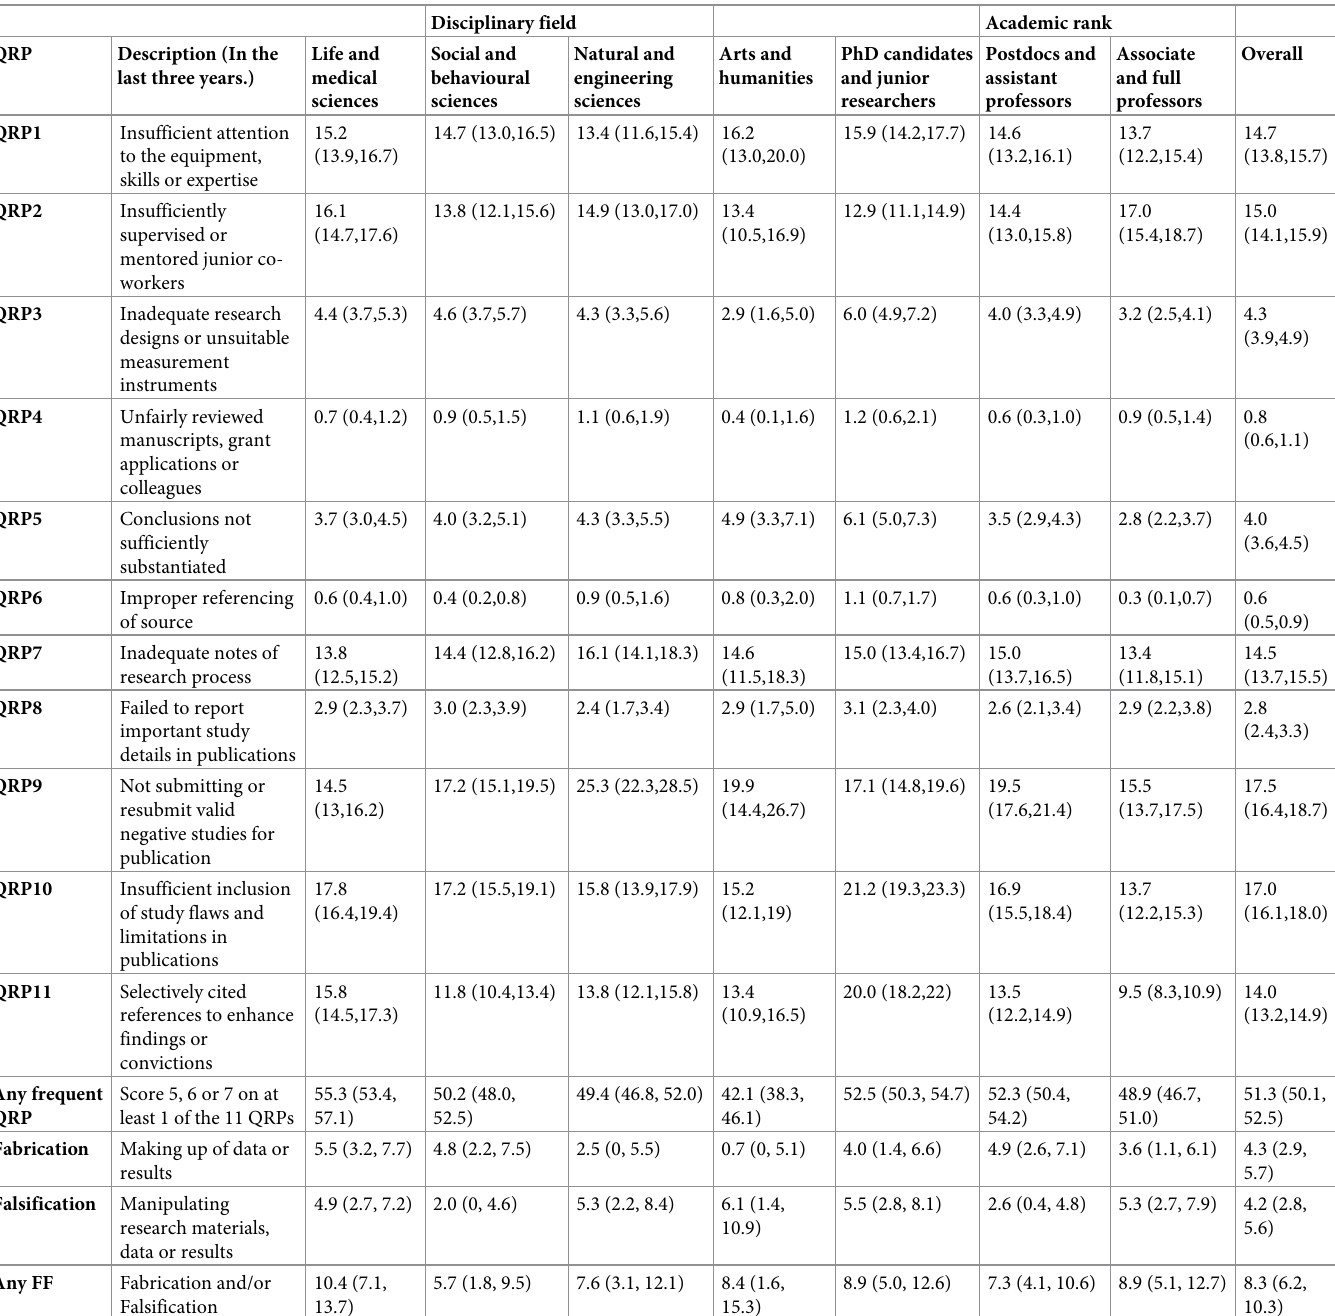
Table 2. Prevalence (95% confidence intervals) of the QRPs, any frequent QRP and fabrication or falsification stratified by disciplinary field and academic rank. QRP Description (In the last three